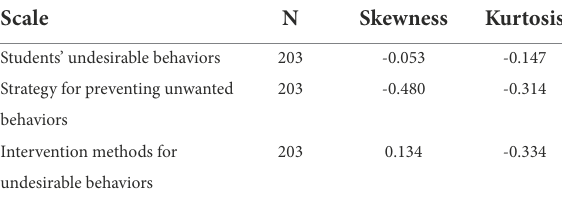
TABLE 1 Skewness and Kurtosis values of